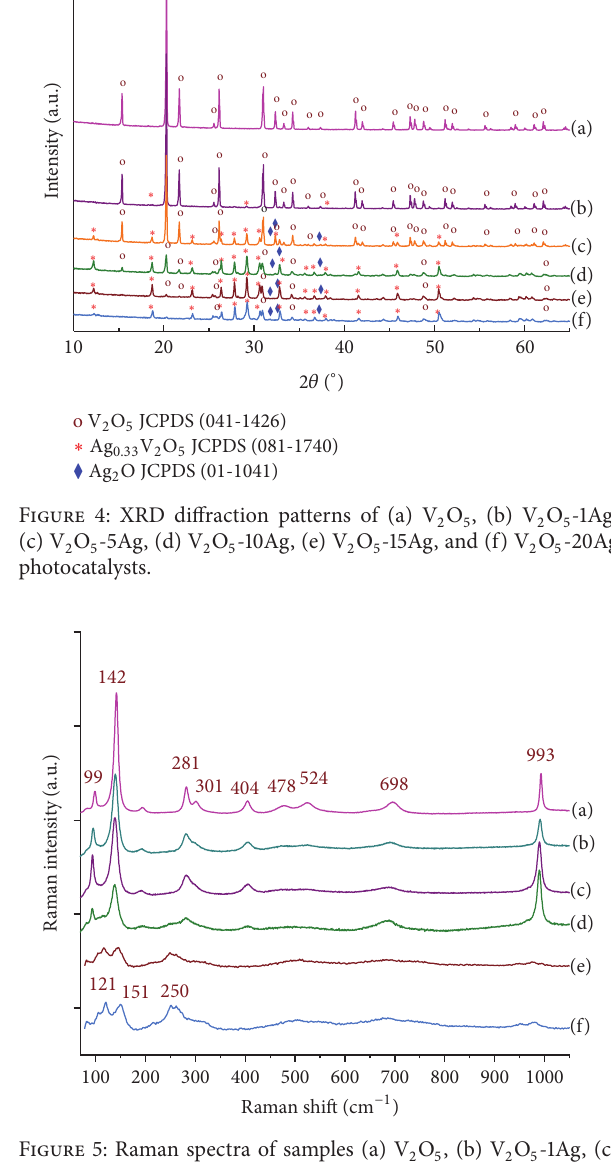
Table 2: Specific surface area ( 𝑆 BET ) and pore volume ( 𝑉 𝑝 ) of pure V 2 O 5 and V 2 O 5 - x Ag photocatalysts.